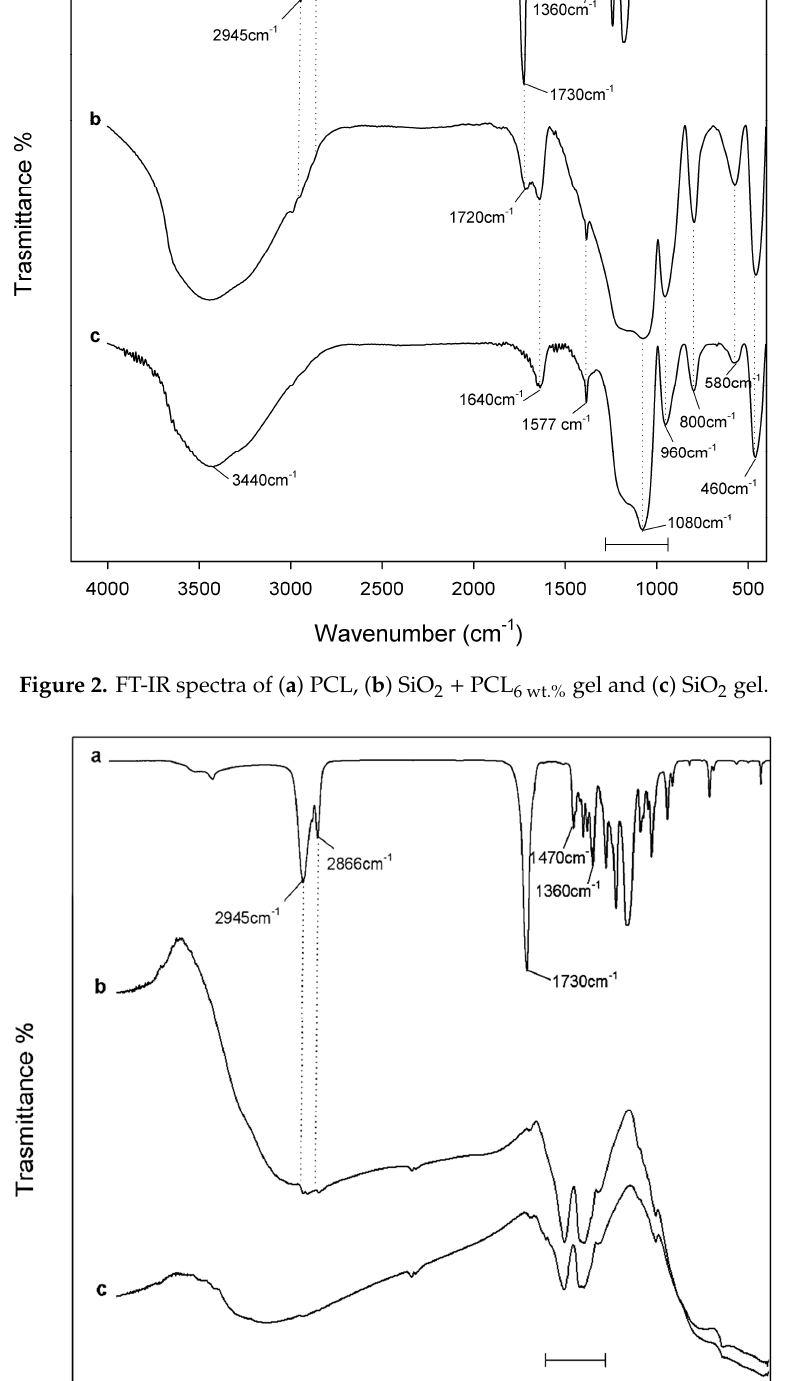
Figure 3. FT-IR spectra of ( a ) PCL, ( b ) TiO 2 + PCL 6 wt.% gel and ( c ) TiO 2 gel.